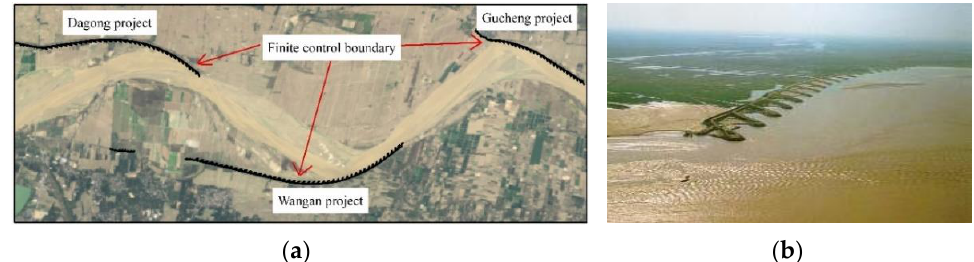
Figure 2. River channel with a finite control boundary: ( a ) Local reach in the lower Yellow River; ( b ) river regulation project in the lower Yellow River.